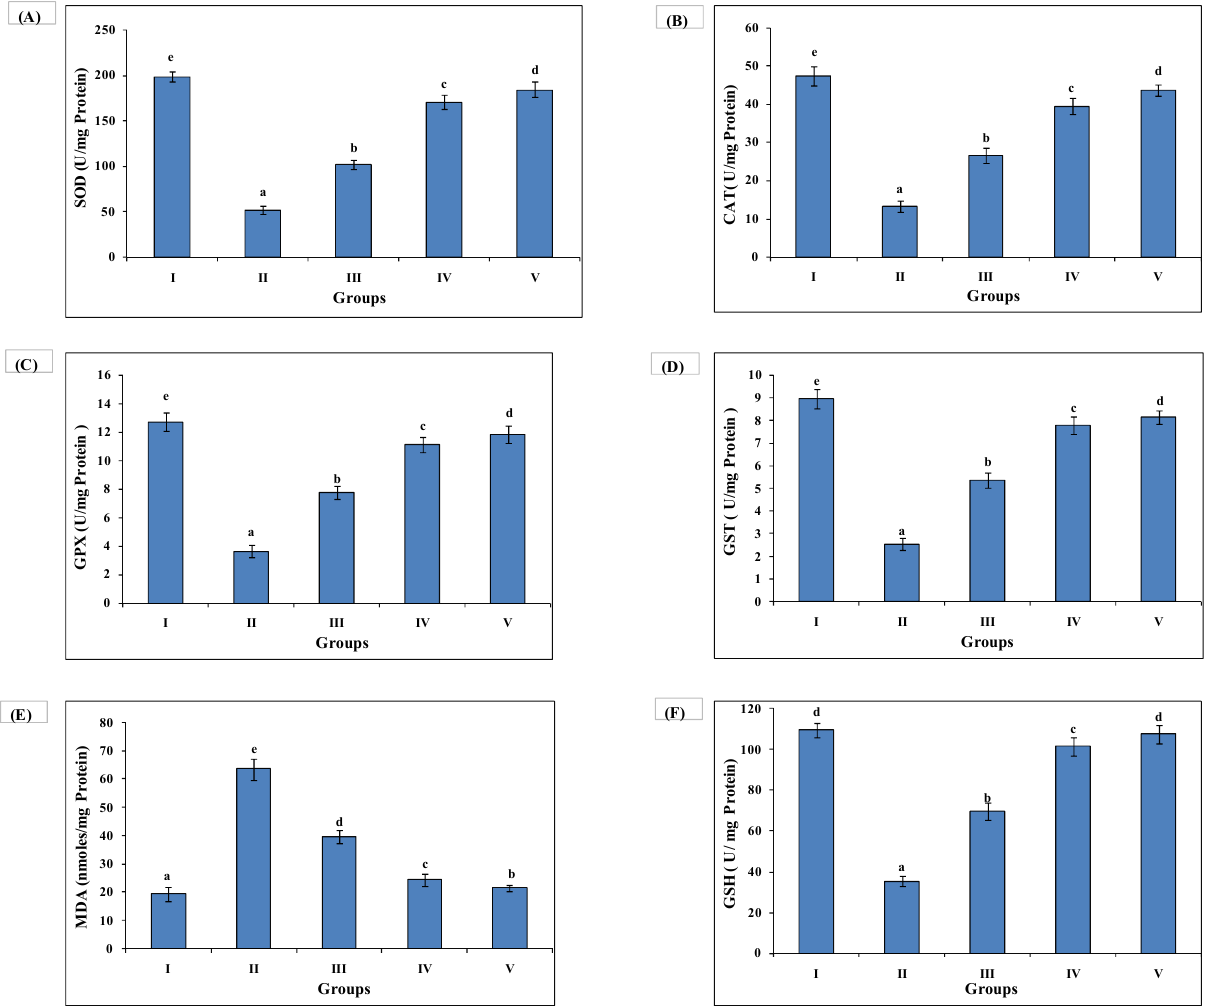
Figure 3. AAE treatment improves antioxidant enzyme activity and lowers lipid peroxidation. Higher antioxidant enzymes activities ( A ) SOD (U/mg protein), ( B ) catalase (U/mg protein), ( C ) GPX (U/mg protein), ( D ) GST (U/mg protein) ( E ) LPO (nmoles/mg protein) ( F ) GSH (U/mg protein) and lowered stress marker declined in AAE-treated Groups III and IV, where values of Group IV were close to those of silymarin-treated Group V. Group II had the lowest antioxidant activities and highest lipid peroxidation. Duncan’s multiple-range test (DMRT) was used for the analysis of a significant difference between the means ( p < 0.05) and separately compared each parameter. Bars with the same letters are not significantly different. All values are means of five replicates ±